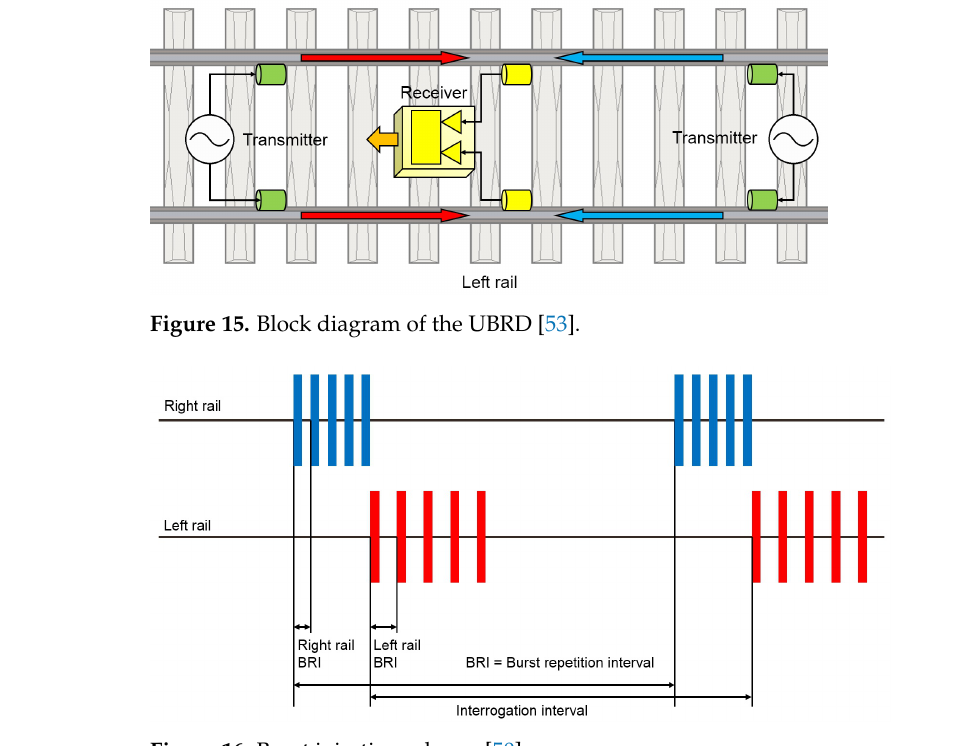
Figure 16. Burst injection scheme